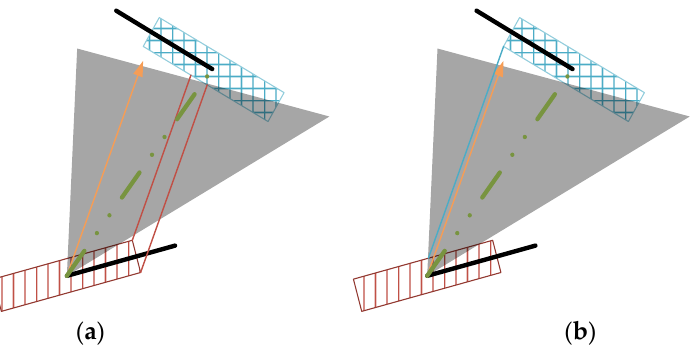
Figure 7. Time of invading the velocity obstacle cone. ( a ) The collision track of vertices of our ship against the target ship. ( b ) The collision track of a vertex of the target ship against our ship. When the relative velocity direction was in the extended velocity obstacle cone, we went through the four vertices of our ship, created a straight line parallel to the relative velocity direction, and then calculated the distance from each vertex of the target ship to the straight line, as presented in Figure 8. Among the 16 calculated distances, the vertex of the target ship with the smallest corresponding distance was the point closest to our ship during the voyage, and the perpendicular foot from this point to the corresponding straight line was the nearest point (the intersection of the purple dotted line and the red dotted line). The length of the nearest fixed-point track (i.e., purple dotted line in the figure) from our ship to the target ship was d min . The value of TVOI was d min / v r . Equation (13) was used to calculate TVOI.